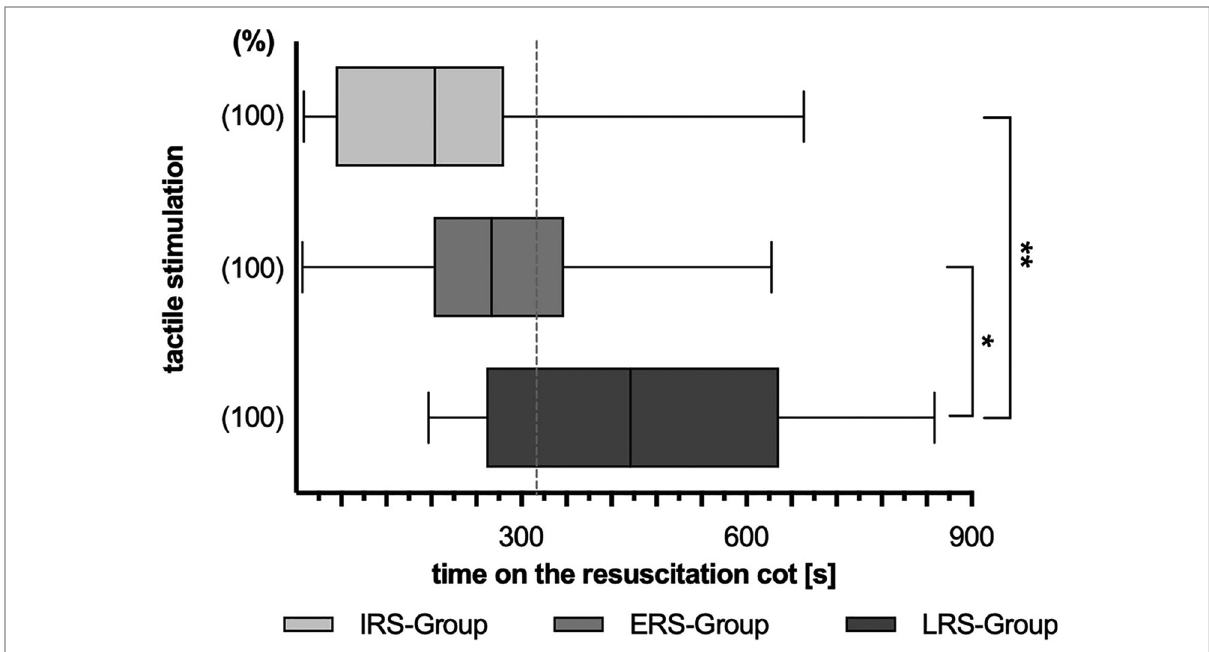
FIGURE 2 Overall duration of active tactile stimulation (TS) during the fi rst 15 min of postnatal support. Three subgroups are depicted: LRS, late respiratory stability group; ERS, early respiratory stability group; IRS, immediately respiratory stability group, no need of iPPV or INFL within the fi rst 15 min of postnatal support. (%) – proportion of infants within the particular group; p -values - ** p =0.003, * p